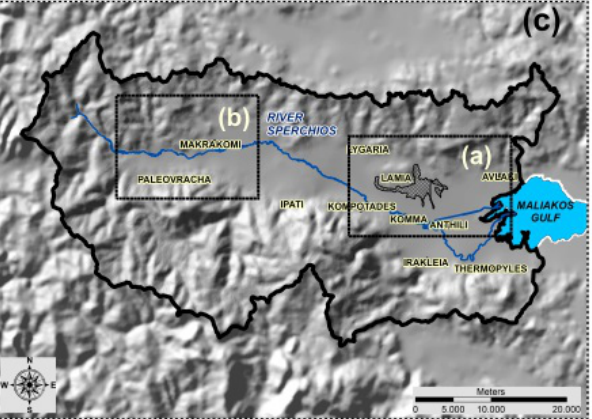
Figure 5. ( a ) Principal Component Analysis (Principal Component 1), ( b ) False Color Composite image (7,5,3 RGB), of Landsat 7 ETM+ for the validation and completion of the lineament map of the area (red lines presenting lineaments recognized and digitized through the visual interpretation of the images) and ( c ) an image showing the location of ( a , b ) zoomed areas.